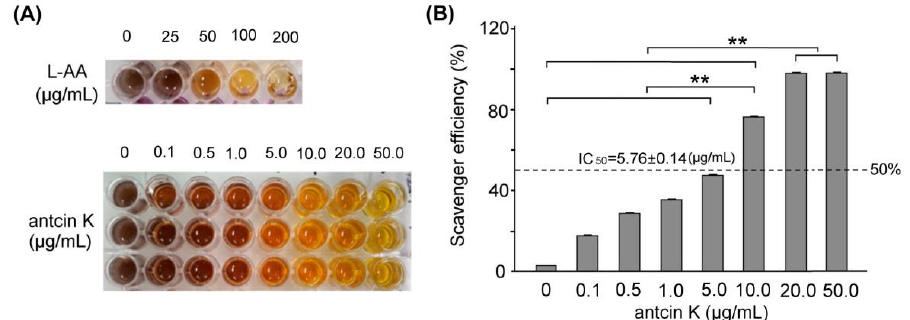
Figure 2. Antioxidative capacity of antcin K. ( A ) DPPH assay using various concentrations of antcin K treatment for 30 min. L-ascorbic acid is a standard antioxidative compound. ( B ) Comparison of the quantified DPPH free radical scavenging activity among antcin K treatments at 0 – 50 μ g/mL. IC 50 of antcin K was 5.76 ± 0.14 μ g/mL ( n = 3 for each group; values are presented as mean ± SEM, ** p < 0.001, one-way ANOVA followed by the Student – Newman – Keuls multiple comparison post hoc test).